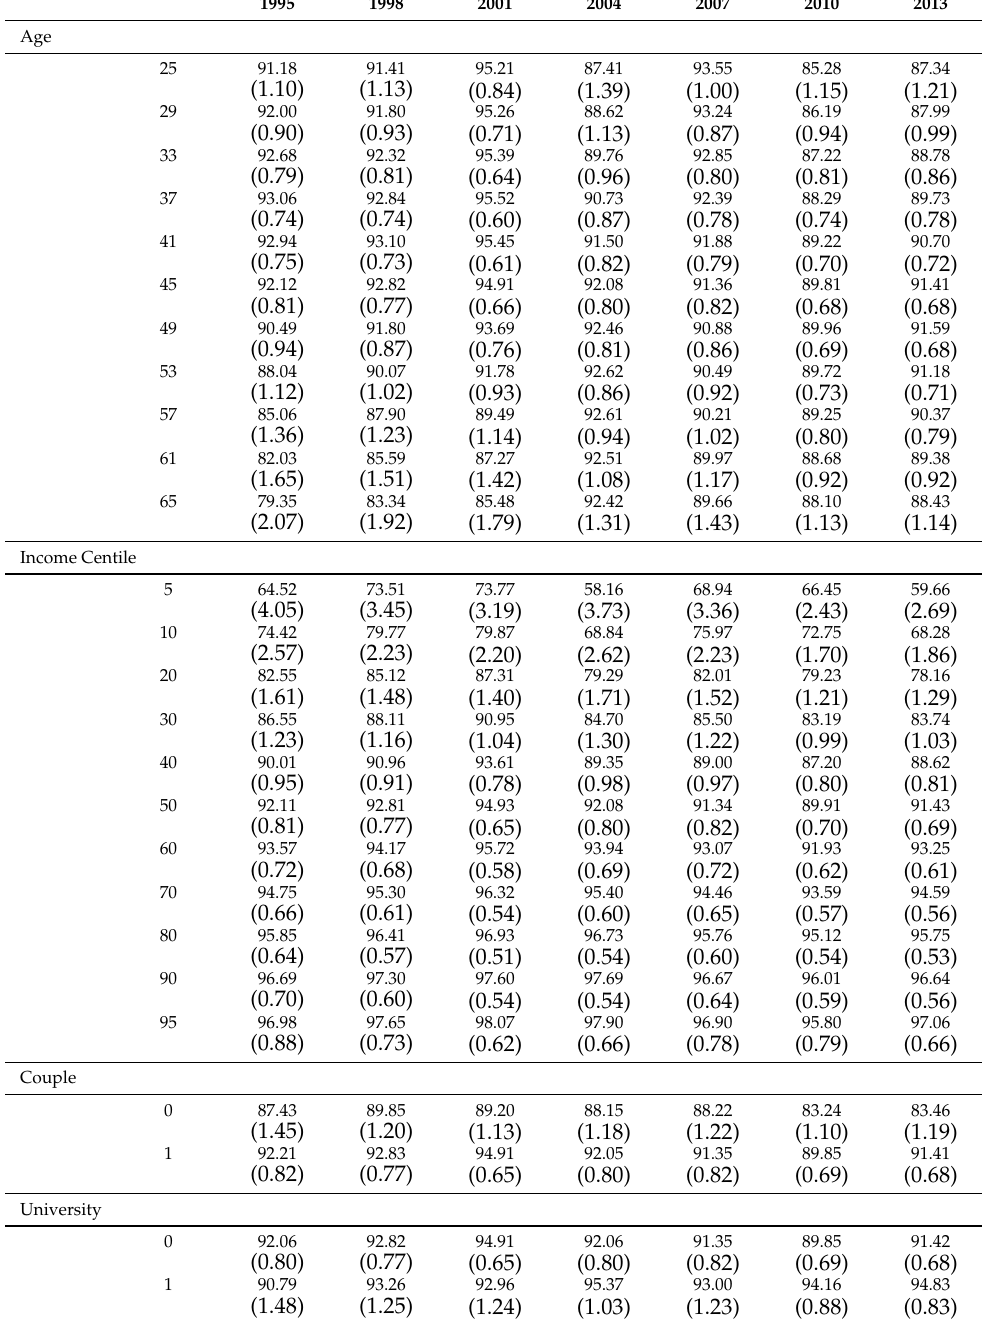
Table A7. Estimates of Whether Credit Applicant is Given Loan for